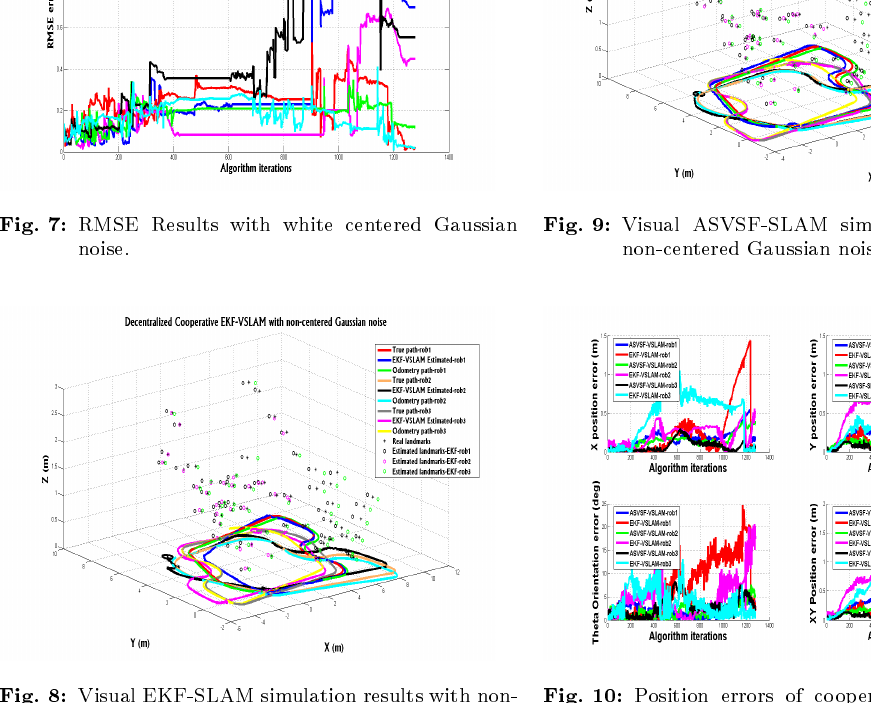
Fig. 10: Position errors of cooperative Visual SLAM with non-centered Gaussian